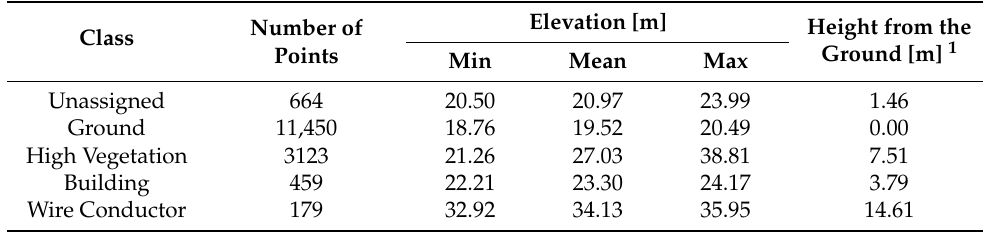
Figure 3. ( a ) Results of the first preprocessing: point cloud image colored by class. ( b ) Results of the second preprocessing: point cloud image colored by elevation. Table 2. Summary of the point cloud properties for the five classes.